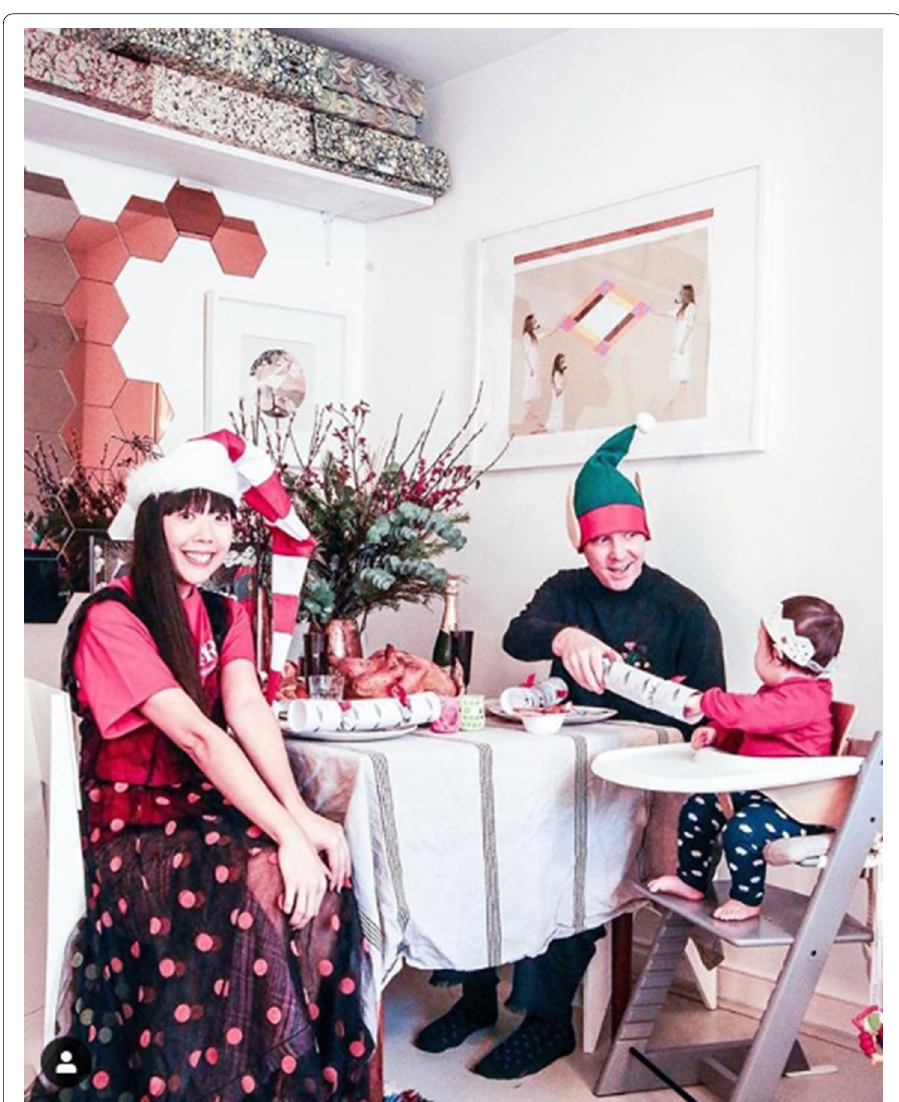
Fig. 7 Auditioning for next year’s round of Christmas. https ://www.insta gram.com/p/BdFrC G-lkmC/. Accessed 14 September